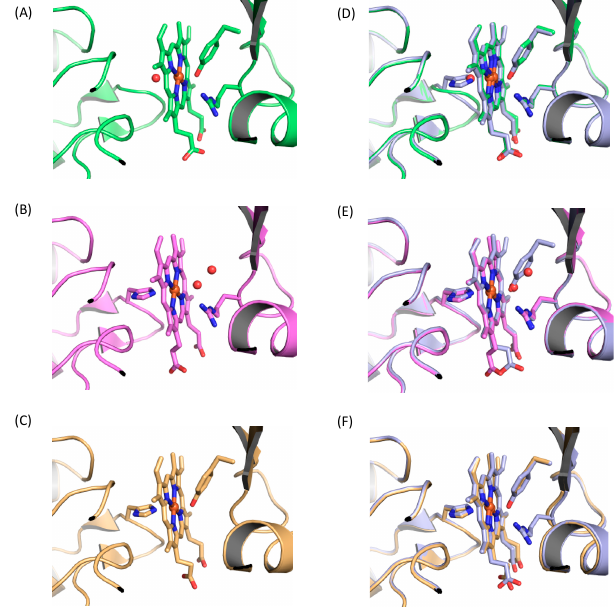
Figure 2. Heme environmental structure of ( A ) H141A mutant (green), ( B ) Y240A mutant (magenta), and ( C ) R242A mutant (gold). Structural comparison between wild-type (WT) (gray) and ( D ) H141A mutant, ( E ) Y240A mutant, and ( F ) R242A mutant. A red ball represents a water molecule.